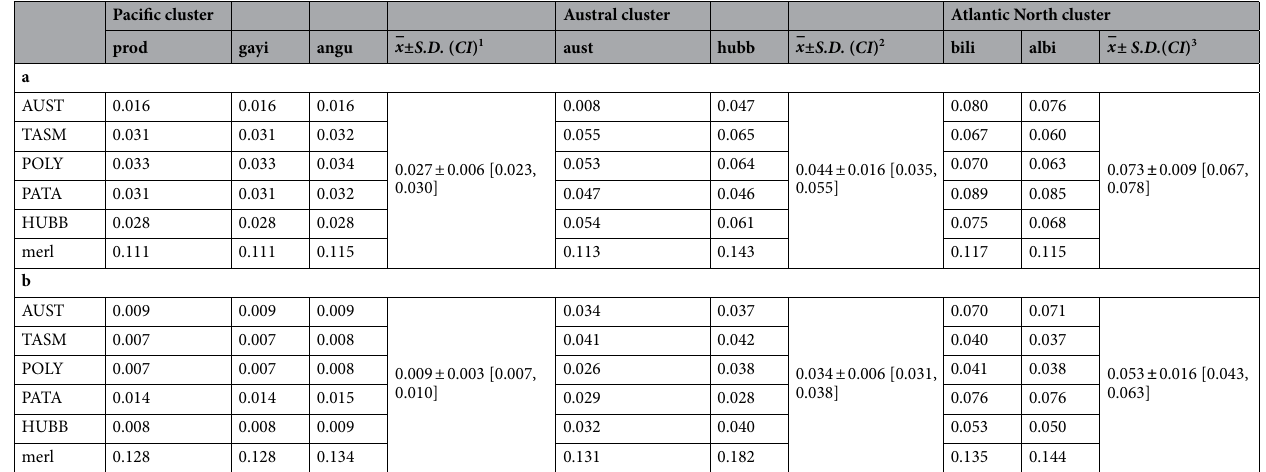
Table 4. (a) Average number of nucleotide substitutions per site ( D xy ) between New World hakes (three clusters) and hake morphotypes under test (in capitals) as generated with DnaSP v5.10.1 77 , (b) Estimates of the Net Evolutionary Divergence ( d ) between New World hakes and hake morphotypes as generated with MEGA v7.0.20 76 . Both estimates were computed on ITS1Nes sequences and used the European hake (merl) as a relative measure of divergence. 1 D xy average ( a ) or d ( b ) on pairwise comparisons between Pacific hakes ( M. productus , M. gayi and M. angustimanus ) and hake morphotypes (in capitals). 2 D xy average ( a ) or d ( b ) on pairwise comparisons between Austral hakes ( M. australis and M. hubbsi ) and hake morphotypes (in capitals). 3 D xy average ( a ) or d ( b ) on pairwise comparisons between Atlantic North hakes ( M. bilinearis and M. albidus ) and hake morphotypes (in